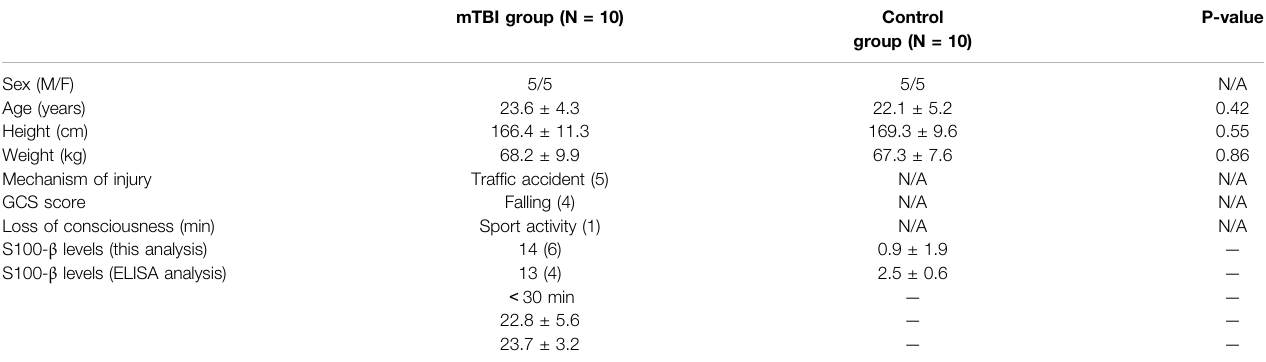
TABLE 1 | mTBI Patients ’ group characteristics comparison using biosensor analysis and